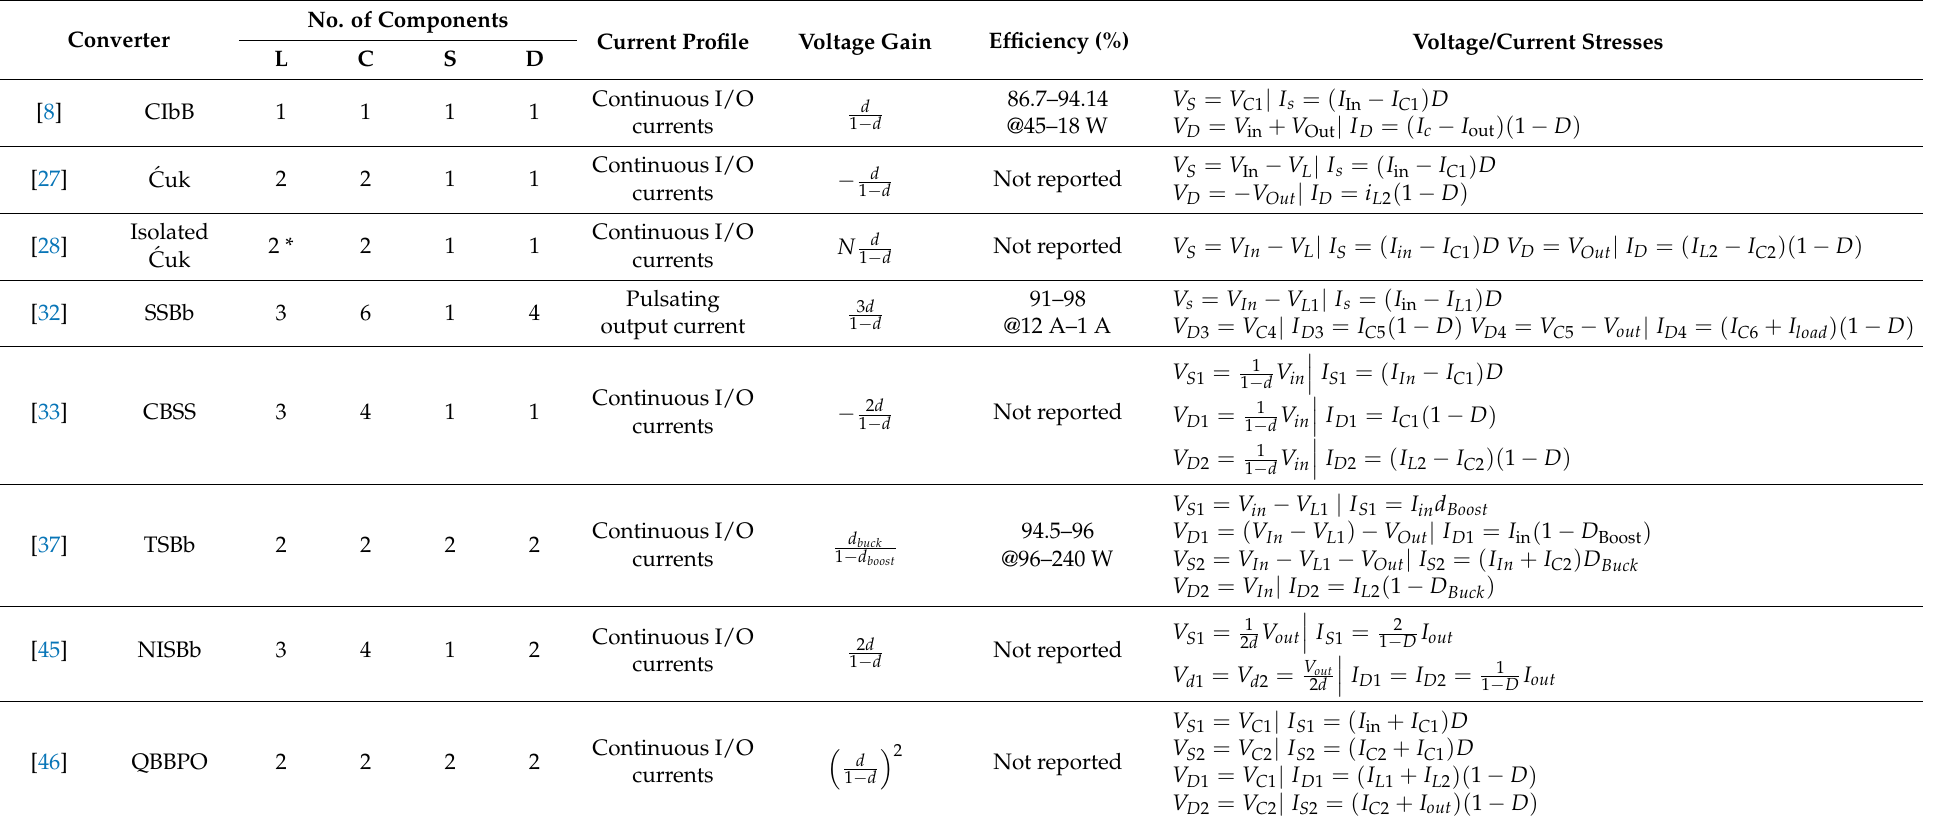
Table 1. Comparison between the state-of-the-art converter topologies suitable for FC